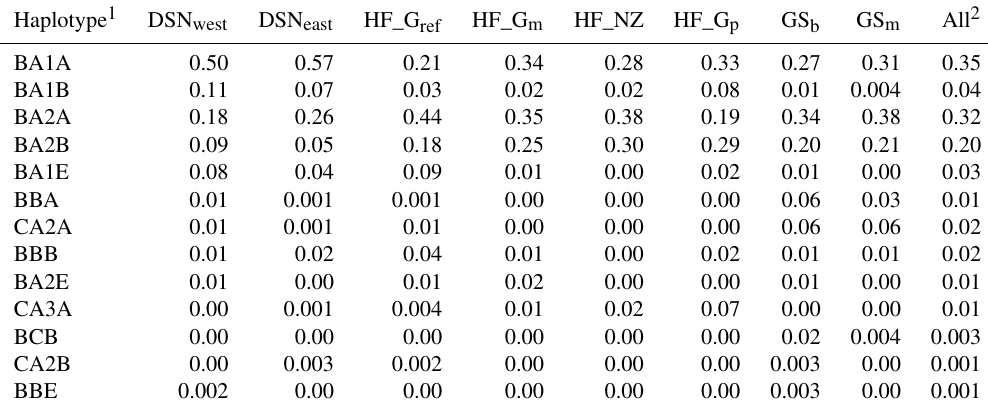
Table 4. Haplotype frequencies in the studied selection lines.